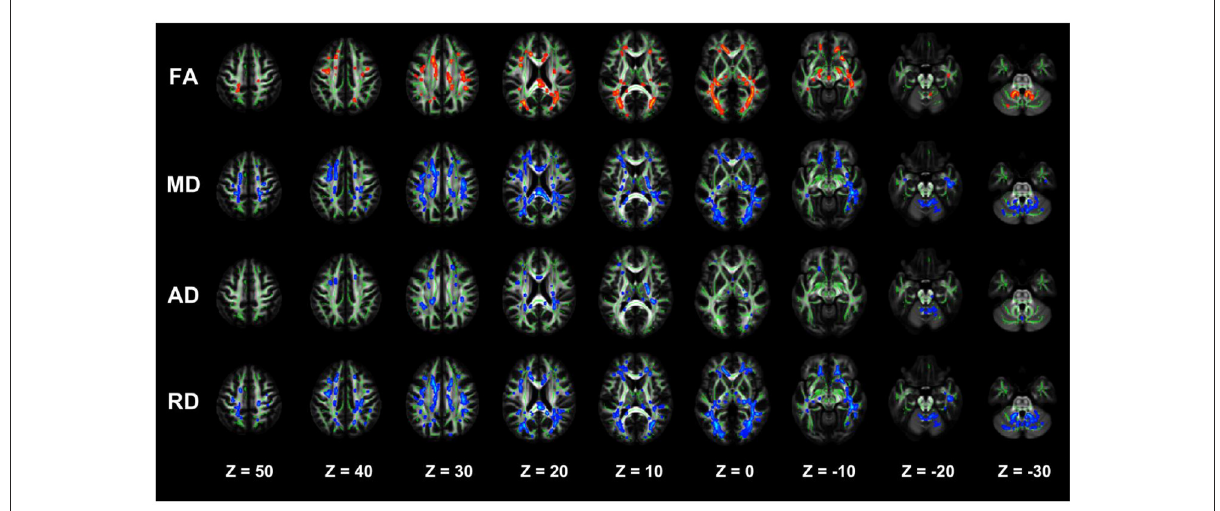
FIGURE2 TBSS analysis showing abnormal white matter bundles for DTI parameters, with the FA, MD, AD, and RD difference areas between the DD-CKD and NC groups. Red color indicates significantly increased white matter bundle parameters, and blue color indicates significantly decreased white matter bundle parameters. Green color represents the mean FA frame for all subjects. FA, fractional anisotropy; MD, mean diffusivity; AD, axial diffusivity; RD, radial diffusivity; TBSS, tract-based spatial statistics; DTI, diffusion tensor imaging.